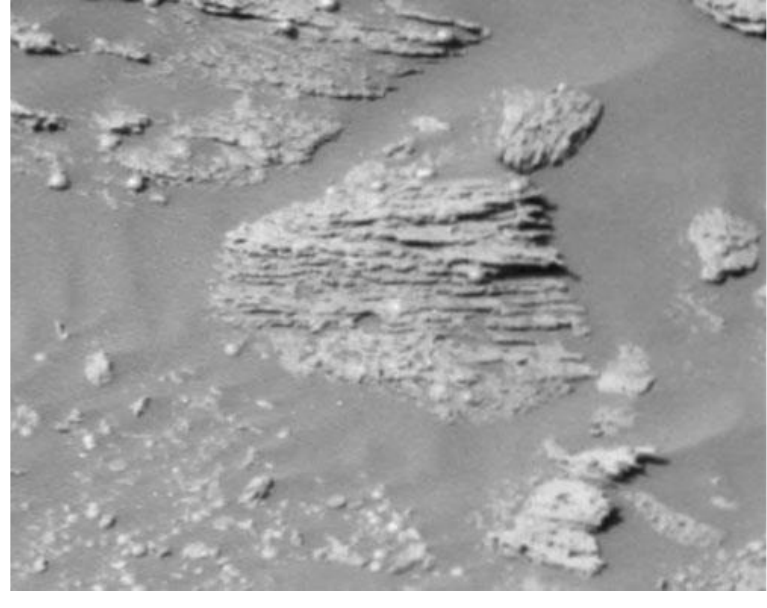
Figure 20. Thin rock layers, not all parallel to each other.